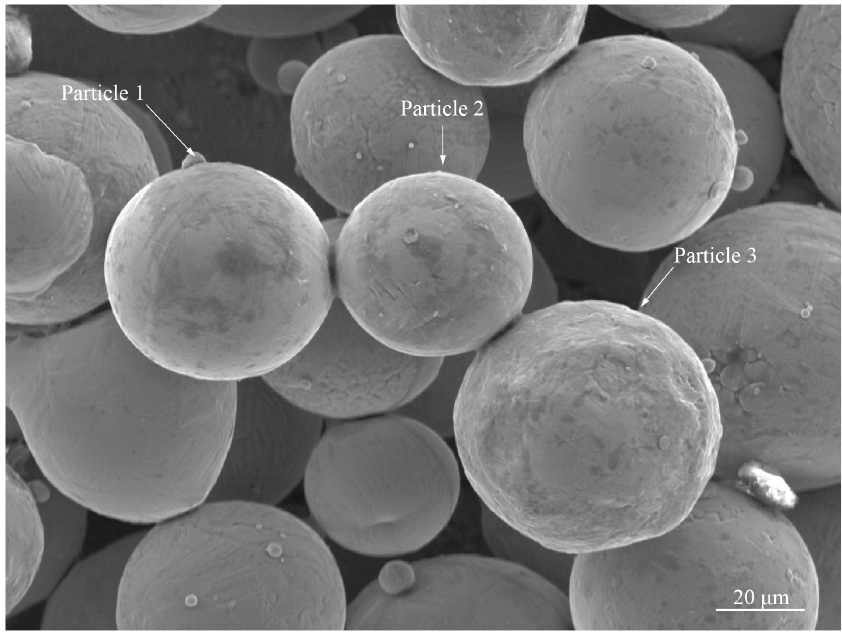
Figure 5. System of three powder particles adopted to tune the RBM parameters.